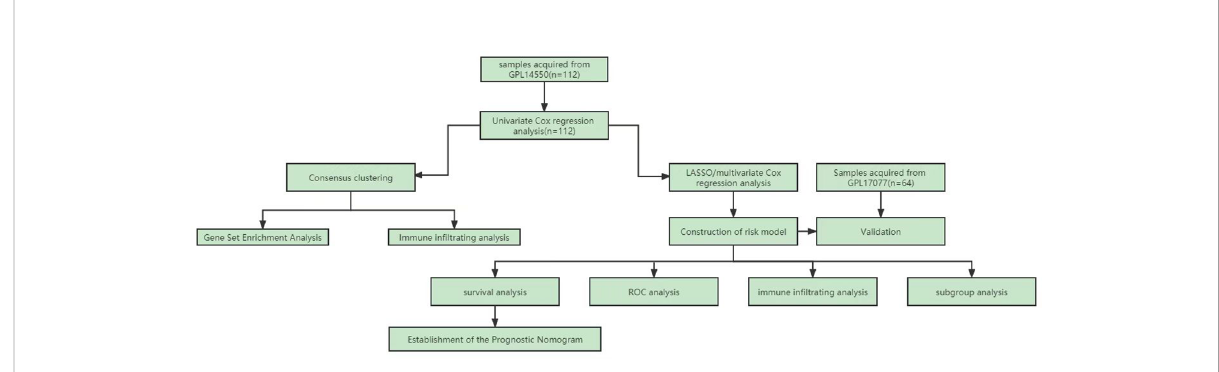
FIGURE 1 The fl ow chat of this